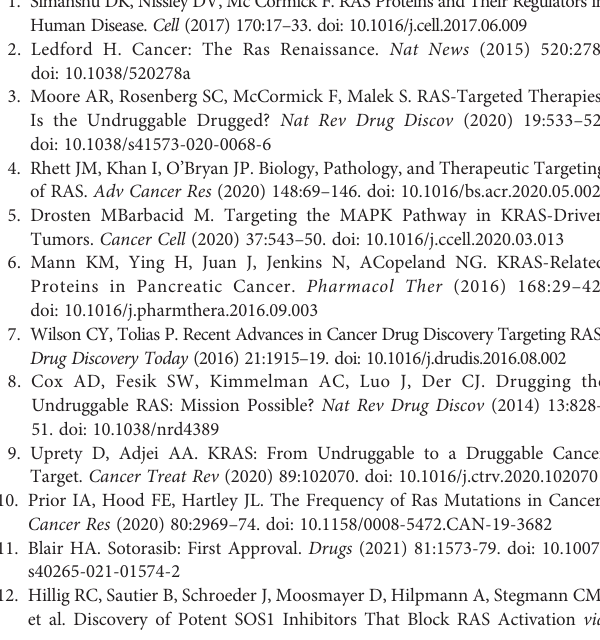
Supplementary Figure 3 | Apoptosis induction activity of SIJ1795 and SIJ1772 cancer cells harboring mtRAS. Cellswere treated witheach compounds of 1 m M for 24 h and subjected to Alexa Flour 488 conjugated annexin V and propidium iodide staining. Flow cytometry analysis were performed. Supplementary Figure 4 | Migration inhibitory effect of SIJ1795 and SIJ1777 cancer cells harboring mtRAS. Wound healing assay was conducted for cell migration analysis. cell monolayer was scratched and test compounds with 0.01 m M concentration were incubated for indicated time. Cells were stained with crystal violet solution and photographed with 40 × magni fi cation. Supplementary Figure 5 | Invasion inhibitory effect of SIJ1795 and SIJ1777 cancer cells harboring mtRAS. To analyze cell invasion ability, Boyden chamber assay was performed. Wound healing assay was conducted for cell migration analysis. Cell monolayer was scratched and test compounds with 0.01 m M concentration were incubated for indicated time. Cells were stained with crystal violet solution and photographed with 100 × magni fi